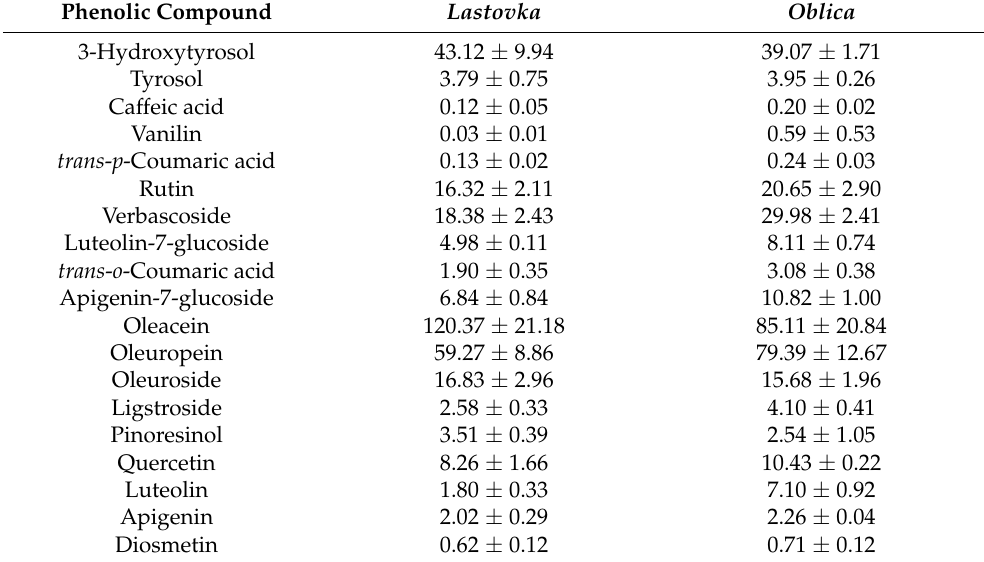
Table 2. Phenolic compounds from olive vegetative bud extract from cvs. Lastovka and Oblica . Phenolic